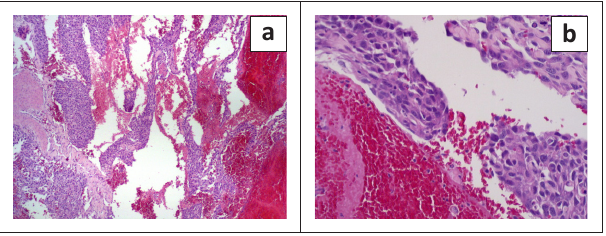
FIGURE 3: Photomicrographs of the mass in the os penis , (a) numerous cavernous blood-filled spaces seen that are lined with monomorphic neoplastic cells (40 x magnification, HE staining) and (b) the mass is densely packed with large cells with indistinct cytoplasmic margins and moderate amounts of finely granular to vacuolar amphophilic cytoplasm and basophilic nuclei (200 x magnification, HE staining).